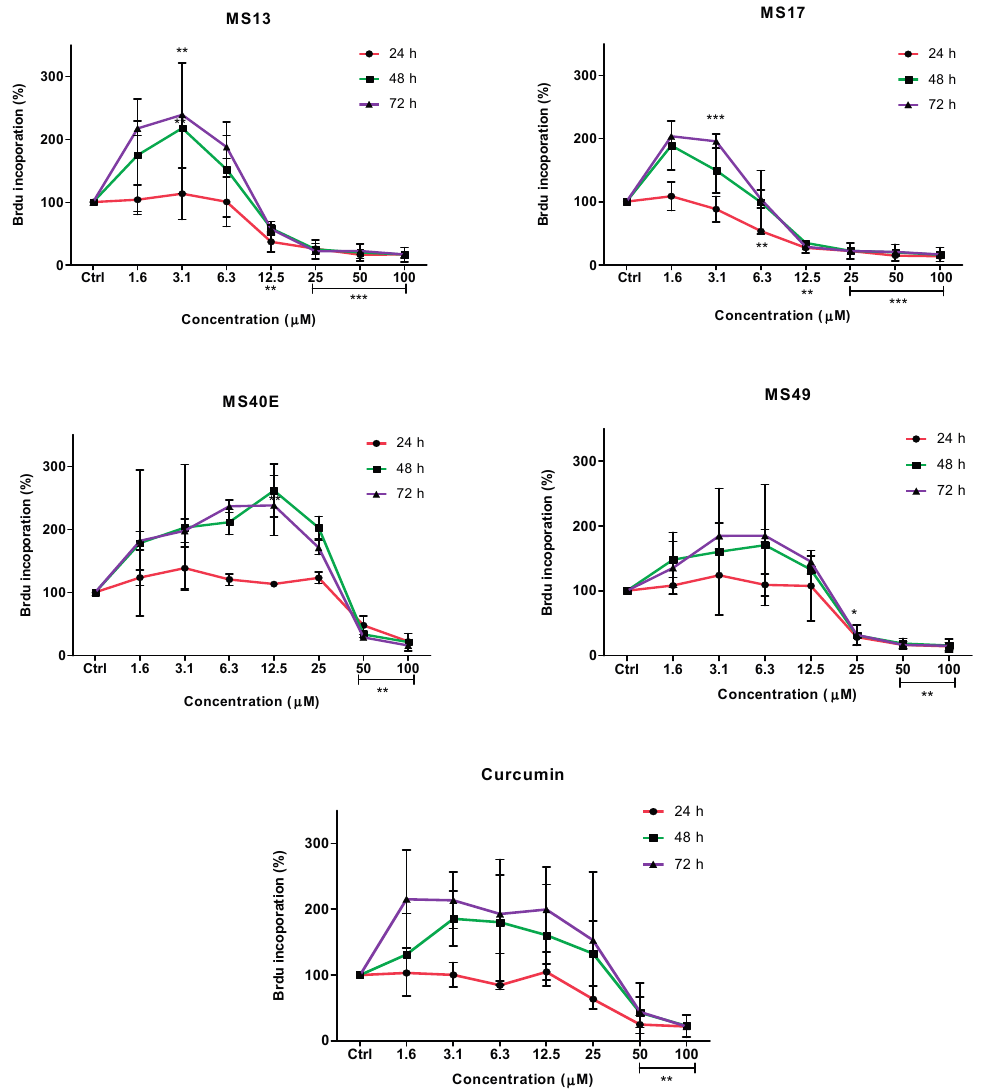
Figure 4. Anti-proliferative effect of MS13, MS17, MS40E, MS49 and curcumin on PC-3 cells at 24, 48 and 72 h. Results are expressed as means ± S.E. from three independent experiments. Percentage BrdU incorporation and comparison between data sets performed using ANOVA. * p < 0.05, ** p < 0.01 and *** p < 0.001 indicates statistically significant differences between the means of values obtained with treated vs. untreated cells